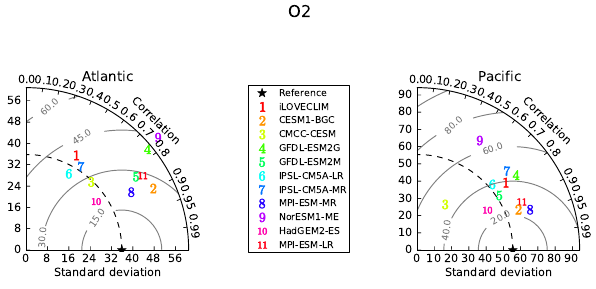
Figure 22. Comparison of the latitude–depth pattern of zonally av- eraged oxygen in the Atlantic and Pacific basins (Taylor diagrams). Data from the World Ocean Atlas 2009 (Garcia et al.,